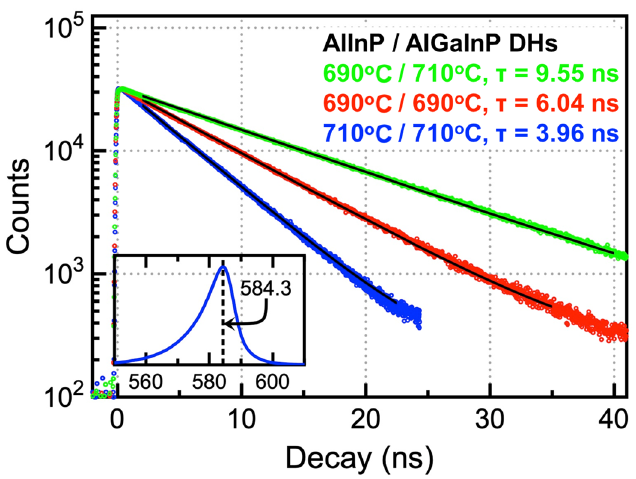
Figure 5. PL decays of AlInP/AlGaInP double heterojunctions grown at varied temperature. The excitation and emission wavelength are 532 nm and 584.3 nm, respectively. The data are fitted using mono-exponential fitting.